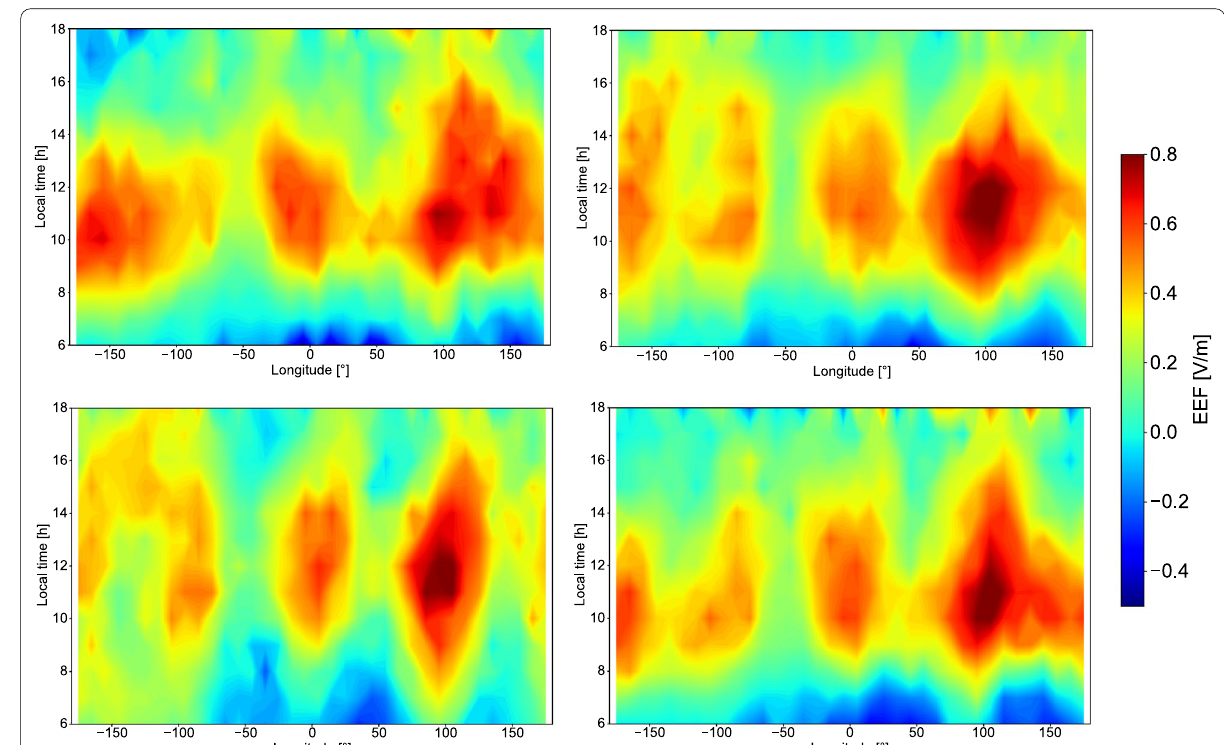
Fig. 8 Seasonal plots of the daytime eastward EEF as measured by the Swarm A and C satellites between 2014 and 2021. The plots in the upper row refer to the winter (left) and spring (right) seasons. The plots in the lower row represent summer (left) and autumn (right)